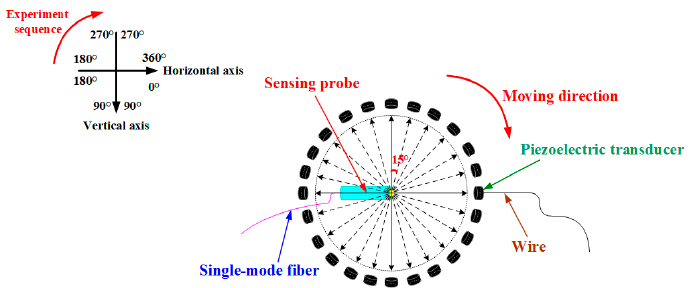
Figure 11. Directional test of this proposed sensor.